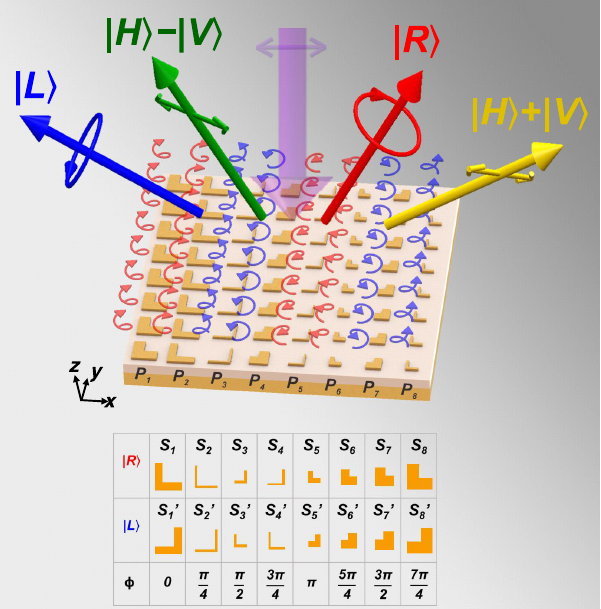
FIG. 1. Schematics showing the generation of multiple coherent beams with a different type of polarization state from a metasur- face made of L -shaped resonators with different geometrical features. The LP incident beam is represented by the purple arrow. Each resonator diffracts a CP state with a certain GSI phase ϕ . By controlling the category and the spatial sequence of the L - shaped resonators in the unit cell, the desired CP (the red clockwise arrow represents RCP, and the blue counterclockwise one represents LCP) and/or LP (illustrated by the large straight arrows) beams can be simultaneously generated. The resonators P j ¼ 1 ; 2 ; … ; 8 Þ form the unit cell of the metasurface. The j ð resonators are selected from the pool f S i g and f S 0 i g ð i ¼ 1 ; 2 ; … ; 8 Þ . The resonators in f S i g generate RCP, and those from f S 0 i g generate LCP, as illustrated in the lower